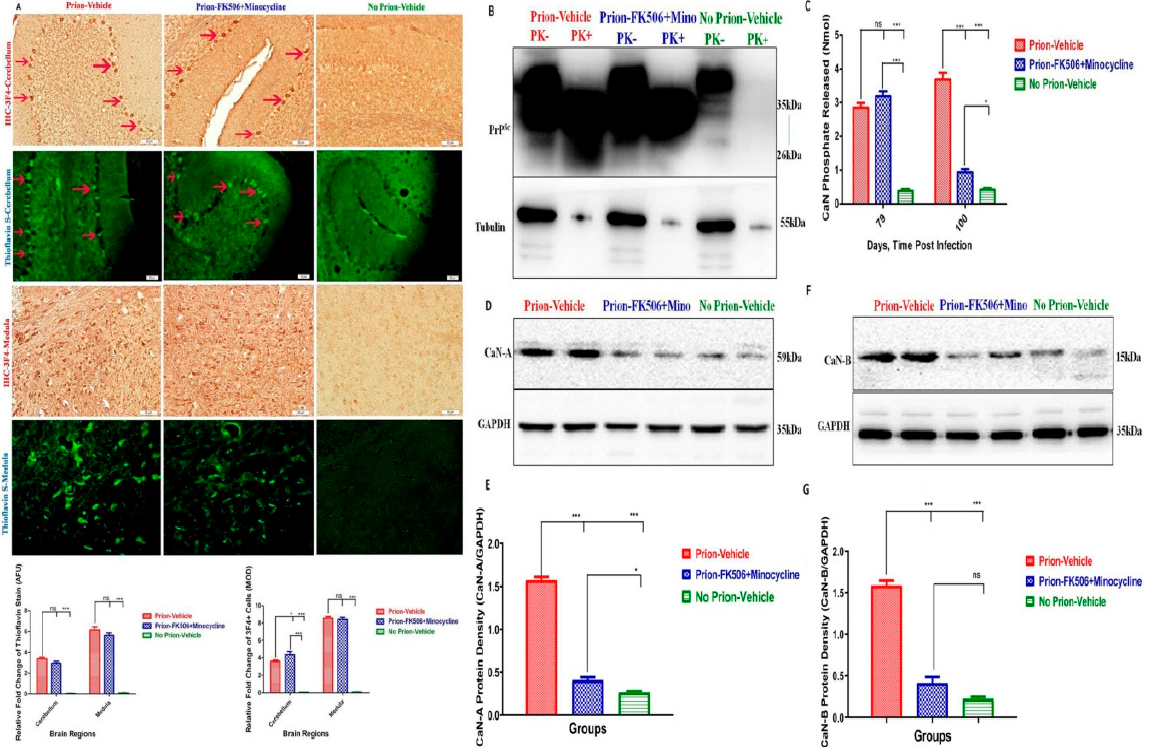
Figure 3. FK506+minocycline treatment partially reduced the calcineurin activity in prion infected hamsters. ( A ) Shows the representative slides for the deposition of PrP Sc in cerebellum and medulla of prion infected and non infected animals stained with 3F4 antibody and thioflavin-S stain (scale bar-50 µ m). Prion deposition in cerebellum is shown with red arrows. Bottom of the figure shows the graphical presentation of prion deposition in prion infected and non infected animals. The data represents 5 animals per group and there was no significant difference observed in the cerebellum with thioflavin-S stain, while slight difference was observed the cerebellum after 3F4 stain. The data was analyzed by using two way ANOVA test followed by bonferroni post hoc test. ( P ≤ 0.05 = *, P ≤ 0.01 = **, P < 0.001 = ***, P > 0.05 = ns) (AFU = arbitrary fluorescence units & MOD = mean optical density). ( B ) Showing representative blots of one animal each per group from prion infected and non infected animals after PK digestion. Total 5 animals from each group were used for western blot analysis. ( C ) Calcineurin activity in response to the accumulation of misfolded proteins, 79th day and 100th day post infection results of prion infected and non infected groups, number of animals tested per group were 3 each time. The data was analyzed by using 2 way ANOVA test followed by bonferroni post hoc test. ( P ≤ 0.05 = *, P < 0.001 = *** and P > 0.05 = ns). ( D ) Shows the representative blots of two animals per group for the catalytic unit of calcineurin (calcineurin-A) expression. ( E ) Statistical analysis of calcineurin-A expression in the brain homogenates from different groups, values were normalized using GAPDH as loading control, number of animals used for statistical analysis per group was 5 and the data was analyzed using one way ANOVA test with post hoc test tukey’s multiple comparison. ( P ≤ 0.05 = * and P < 0.0001 = ***). ( F ) Shows the representative blots of two animals per group for the regulatory unit of calcineurin (calcineurin-B) expression. ( G ) Statistical analysis of calcineurin-B expression in the brain homogenates from different groups, values were normalized using GAPDH as loading control, number of animals used for statistical analysis per group was 5 and the data was analyzed using one way ANOVA test followed by post hoc test tukey’s multiple comparison. ( P < 0.0001 = *** and P > 0.05 =